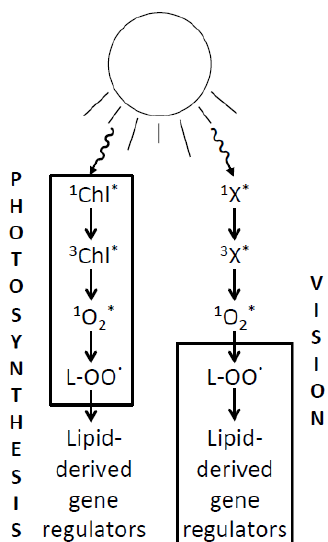
Figure 2. Comparison of photosynthesis and vision with respect to the principal steps in the series of reactions from light absorption, by various chromophores, to transfer of excitation energy to singlet oxygen ( 1 O *) resulting in lipid peroxidation and formation of 2 lipid-derived gene regulators. Light absorption occurs in chlorophyll (Chl)-antenna-protein complexes in photosynthesis, and in retinal-opsin-complexes in vision. Triplet excited chlorophyll ( 3 Chl*) is known to act as the photosensitizer in photosynthesis, passing excitation energy to oxygen, thus forming singlet oxygen. The nature of the photosensitizer in vision (X) is currently under debate. In contrast to protein-bound Chl, opsin-bound retinal does not produce singlet oxygen. However, there is current debate that, once released from opsin, all- trans retinal absorbs another photon and may give rise to singlet oxygen formation (see, e.g., [78]). The boxes around the different phases of the reaction series serve to indicate where research focus has previously been